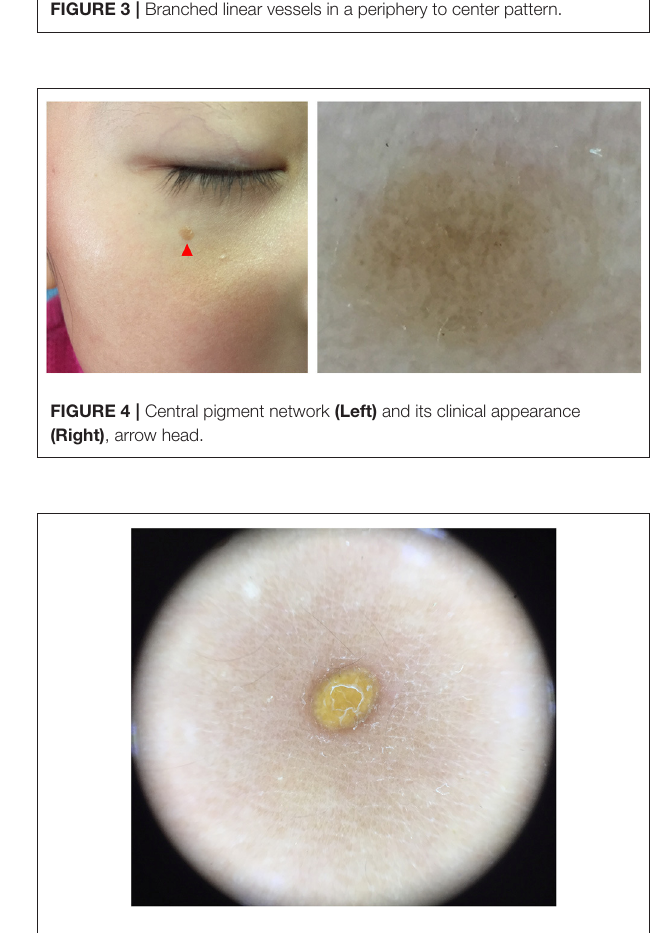
FIGURE 3 | Branched linear vessels in a periphery to center pattern.